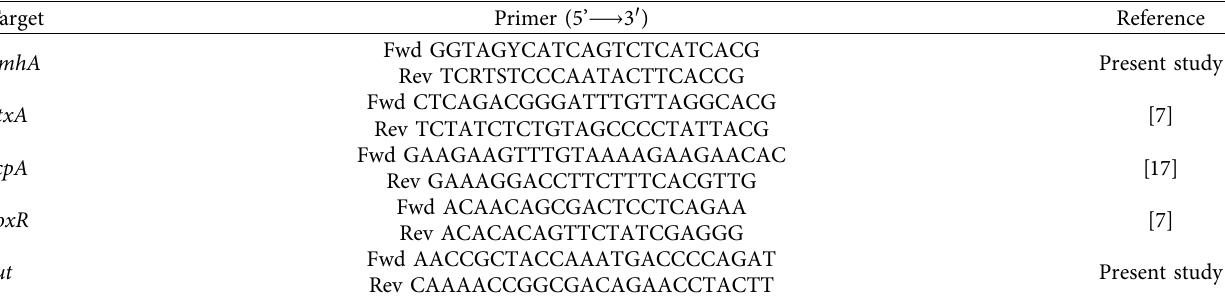
Table 1: :Primers used in this study.